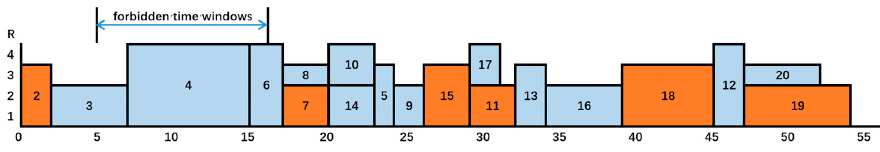
Figure 2. Schedule 1.